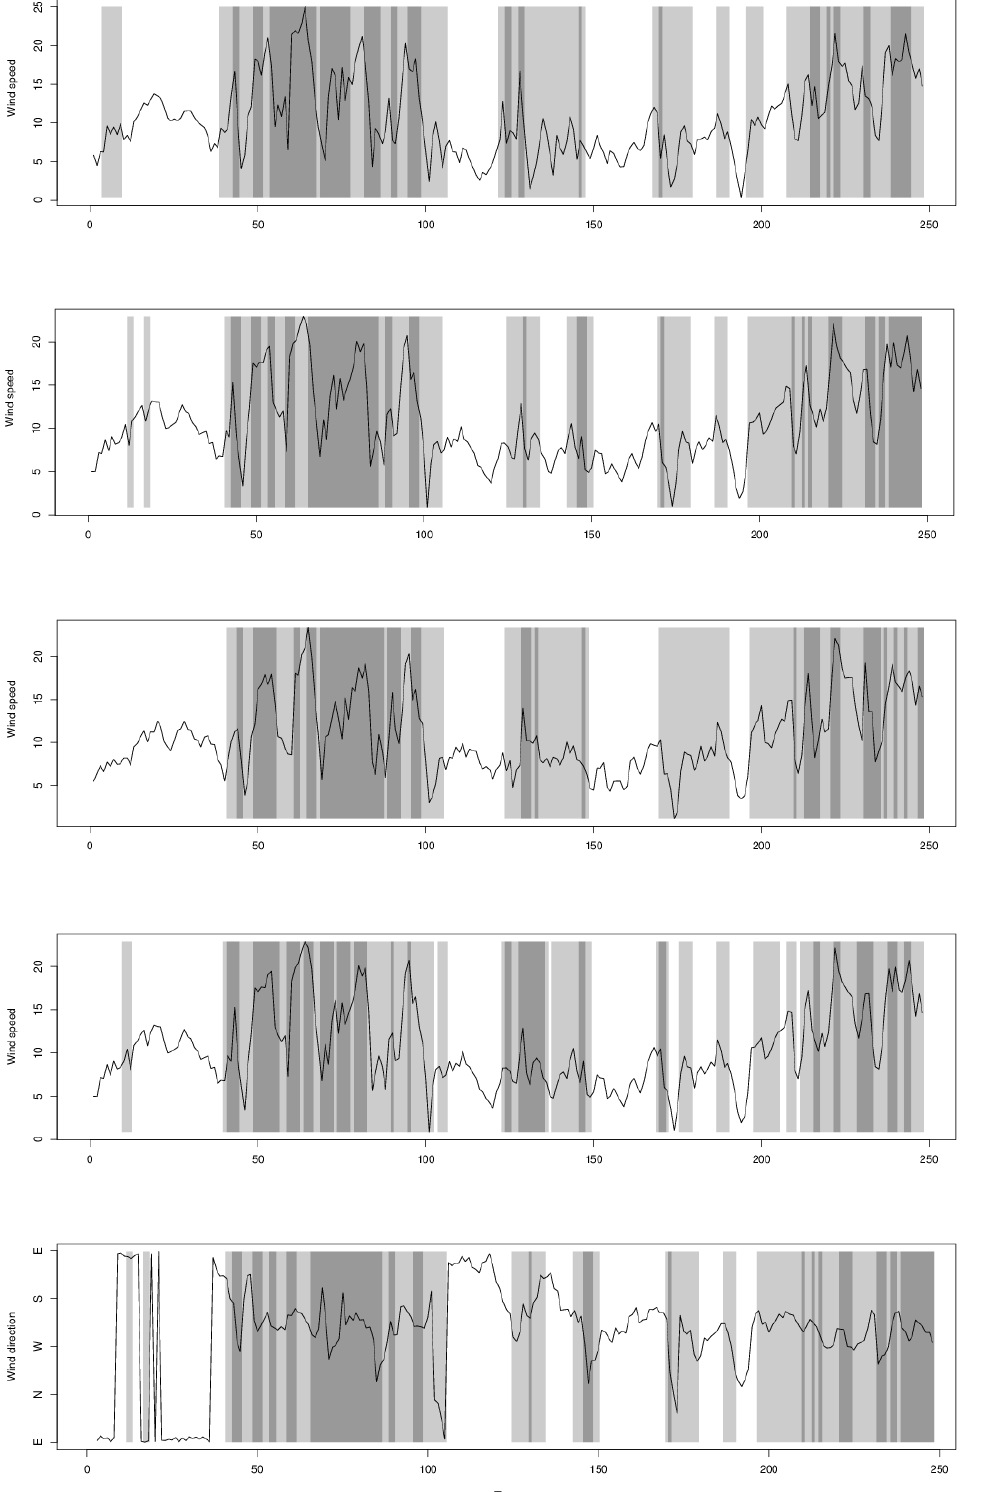
Figure 2. Time series of wind speed in January 2012 and a posteriori regimes from the fitting of a H-MS-VAR. The lighter is the grey; the smaller is the determinant of (cid:54) ( i ) . From top to bottom: sites 1, 10, and 18 when the model is fitted at a single location; fourth panel from the top: extracted regimes when the model is fitted at the five locations (1, 6, 10, 13, 18). Bottom panel: wind direction and regimes at site 10.